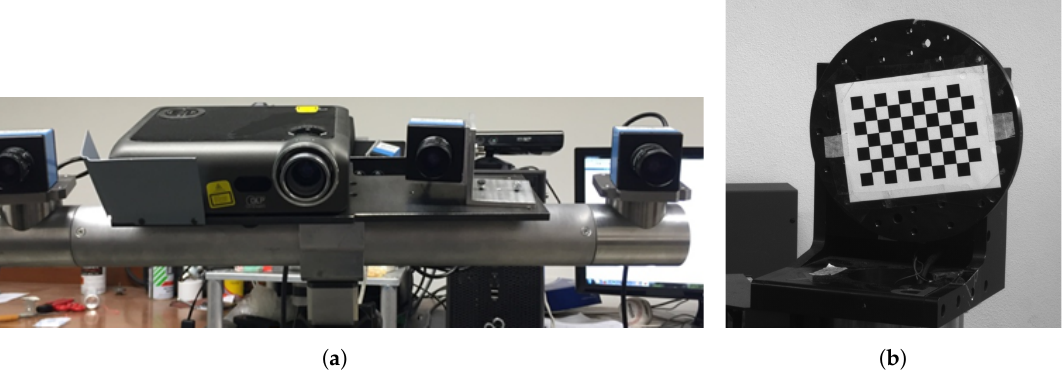
Figure 1. Main instruments used for experimentation: ( a ) stereo-camera system; ( b ) two-axis turntable with Version November 29, 2020 submitted to Sensors checkerboard attached.